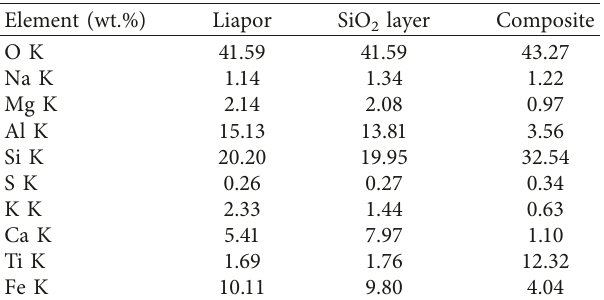
Figure 7: EDS analyses of Liapor. (a) Liapor with the SiO 2 layer. (b) Liapor with the first layer of SiO 2 and two composite layers. Table 4: EDS analysis of